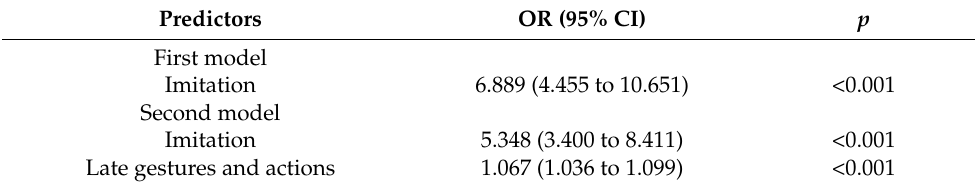
Table 4. Multivariate logistic regression analysis of large vocabulary.